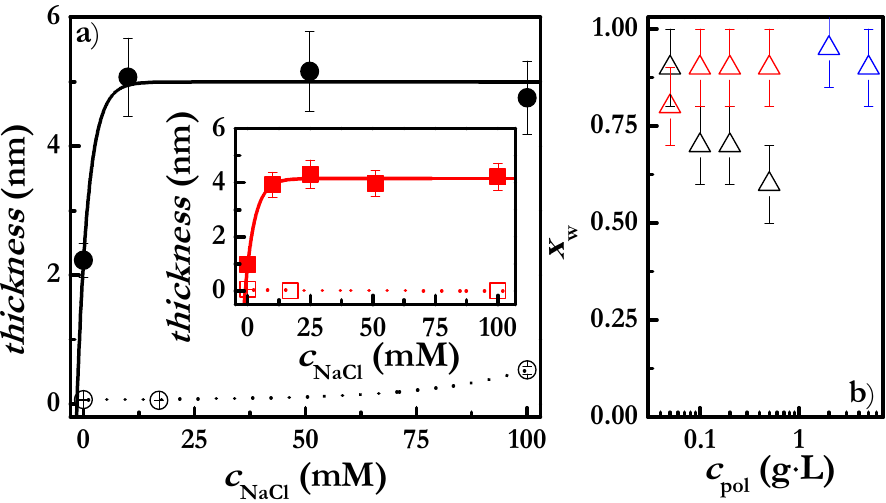
Figure 5. ( a ) NaCl concentration-dependence of the hydrodynamic (solid symbols) and optical thicknesses (open symbols) of CHI layers deposited onto a negatively charged surface from a polymer solution with concentration 5 g/L. The inset corresponds to the same data shown in the main panel for CHI solutions with concentrations of 2 g/L. Note that the reported thicknesses correspond to those obtained after rinsing of the adsorbed layers with aqueous solutions with the same NaCl concentration as that contained in the polymer solutions used for the deposition. ( b ) Dependence of the water content on the polymer concentration for polyelectrolyte layers deposited onto a negatively charged surface: PDADMAC ( ∆ ), JR400 ( ∆ ) and CHI ( ∆ ).